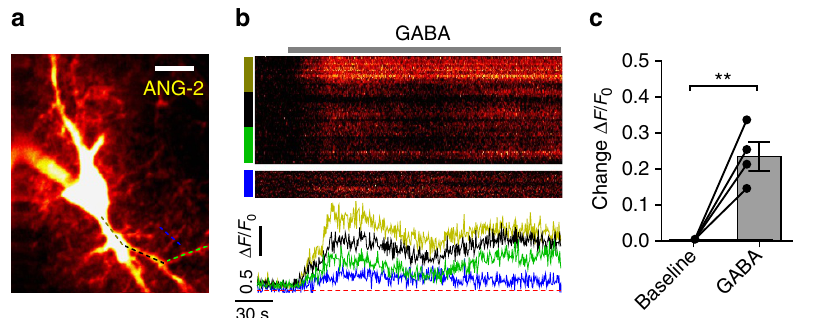
Figure 5 | GABA induces Na þ rise in astrocytic processes. ( a ) Example image of an astrocyte patch loaded with the Na þ indicator ANG-2, dashed colour-coded lines indicate analysed regions in ( b ). Scale bar, 10 m m. ( b ) Upper section: XY-T image displaying ANG-2 fluorescence intensity vs time, separated section shows Na þ signal in fine processes; contrast and brightness were altered to facilitate visualization of the weaker signal. Lower section: colour coded D F / F 0 line plots match regions indicated by coloured bars/dashed lines in upper section and ( a ) respectively. ( c ) Summary plot of peak Na þ indicator response to 30 m M GABA application in fine processes of imaged astrocytes ( n ¼ 4 cells from 4 animals). Error bars represent s.e.m.’s, ** P o 0.01 (paired t -test).